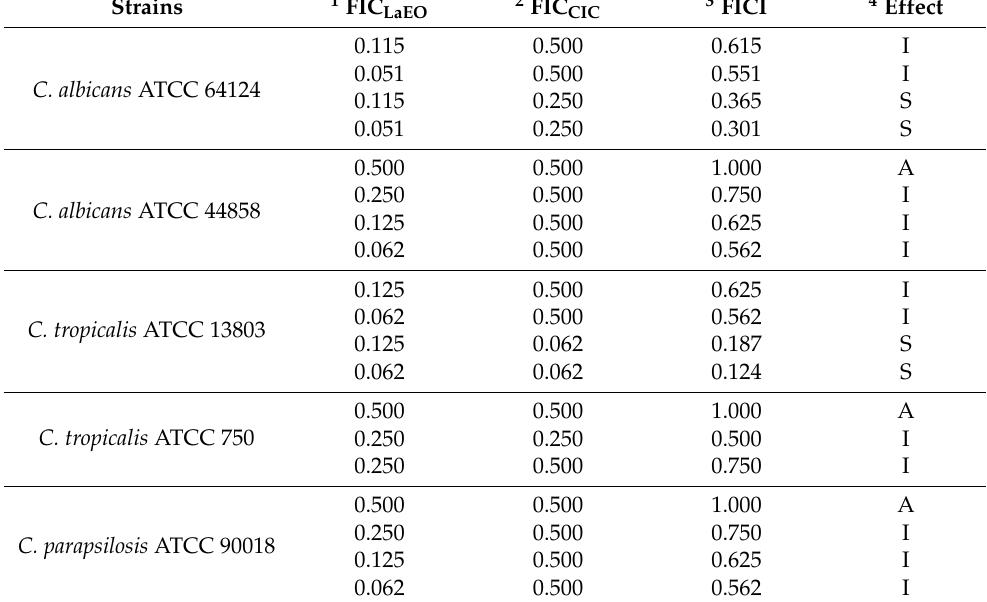
Table 8. Modulatory effect of LaEO on the antifungal activity of ciclopirox olamine (CIC) on Can- dida strains.